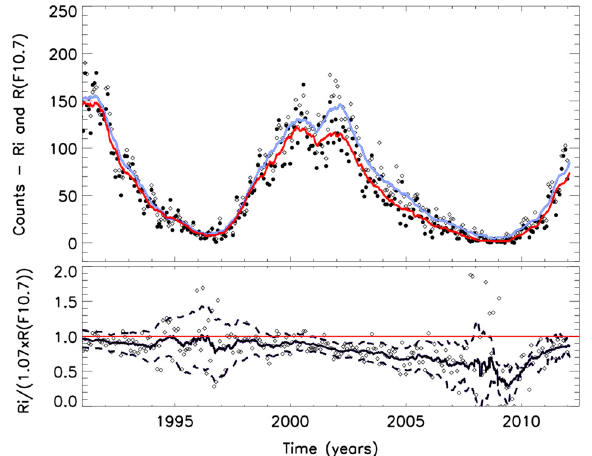
Fig. 10. Comparison of the latest values of the R i index and the Boulder sunspot number from 1991 to the beginning of 2012 (source: NGDC, Boulder. Index based on a few US professional observatories). The lower curve, which gives the ratio and 3 r limits, shows a reversal of the cycle 23 deviation over the early part of cycle 24, like in Fig. 9. Here, the ratio has fully recovered its pre-2000 value by the end of